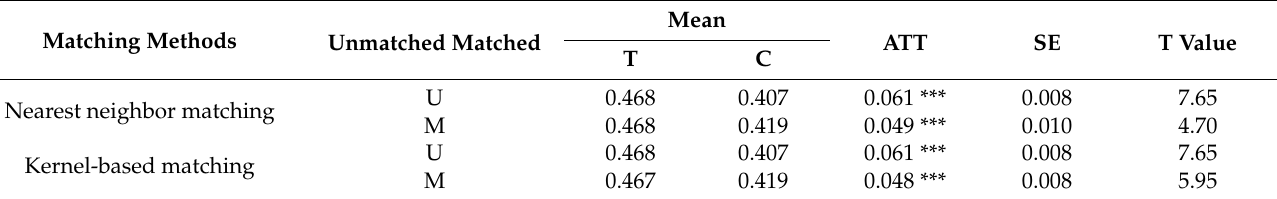
Table 5. The ATT of LCP on land